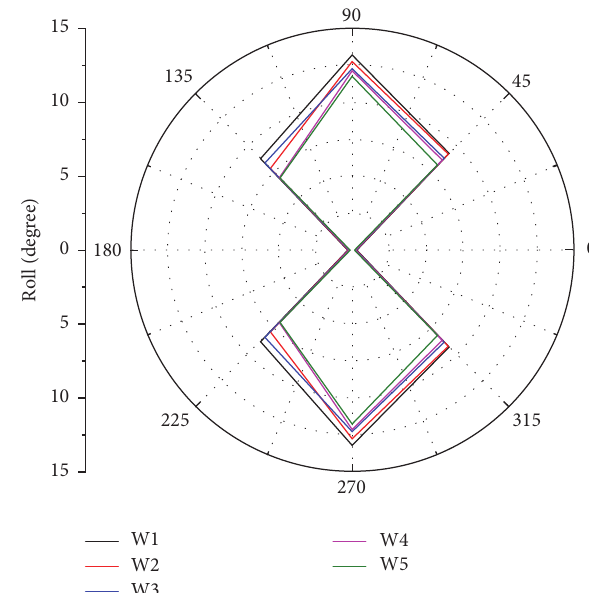
Figure 16: Results of roll in irregular